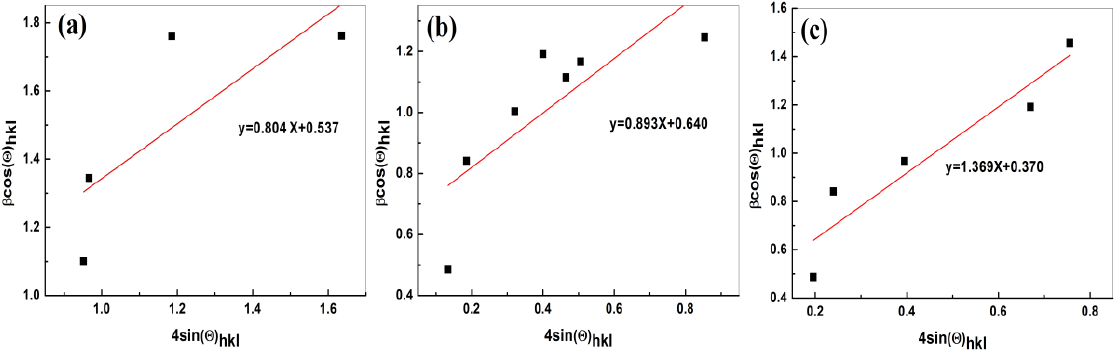
Fig. 3. FE-SEM images of TiO nanorods in (a) pure state (b) doped state with 6 h reflux and (c) 12 h reflux. 2